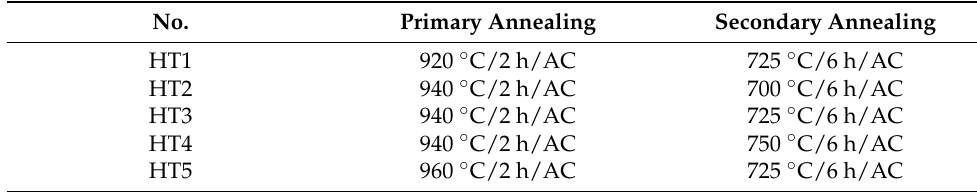
Table 1. The heat-treatment process of the Ti-TiAl laminate composite.